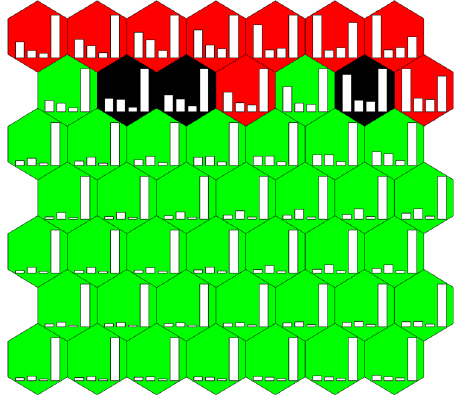
Fig. 4. Clustering results of the 7 × 7dimension SOM. Red, green and black hexagons indicate earthquakes, quarry blasts and unlabeled events. The bar charts in each map unit show the normalized values of complexity, spectral ratio, S/P and time, respectively. Bar chart values are correlated with event discrimination. Values of the first and third bars, which indicate complexity and S/P ratios, respectively, in red cells (earthquakes) are higher than corresponding bars in green cells (quarry blast).